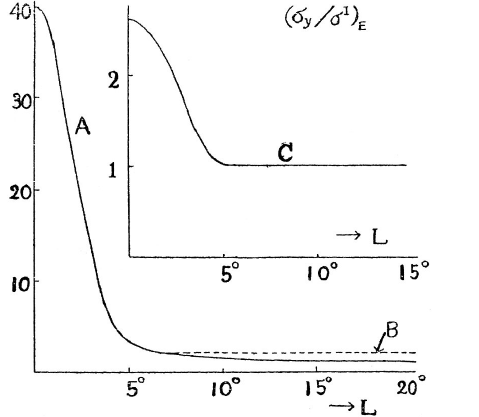
Figure 3. Enhancement of the electric conductivity along the equa- tor when the vertical polarization field produced by Hall current is taken into account. The model A is the relevant case; C is a refer- ence model where carriers of the negative charge are assumed to be negative ion (Hirono, 1950).